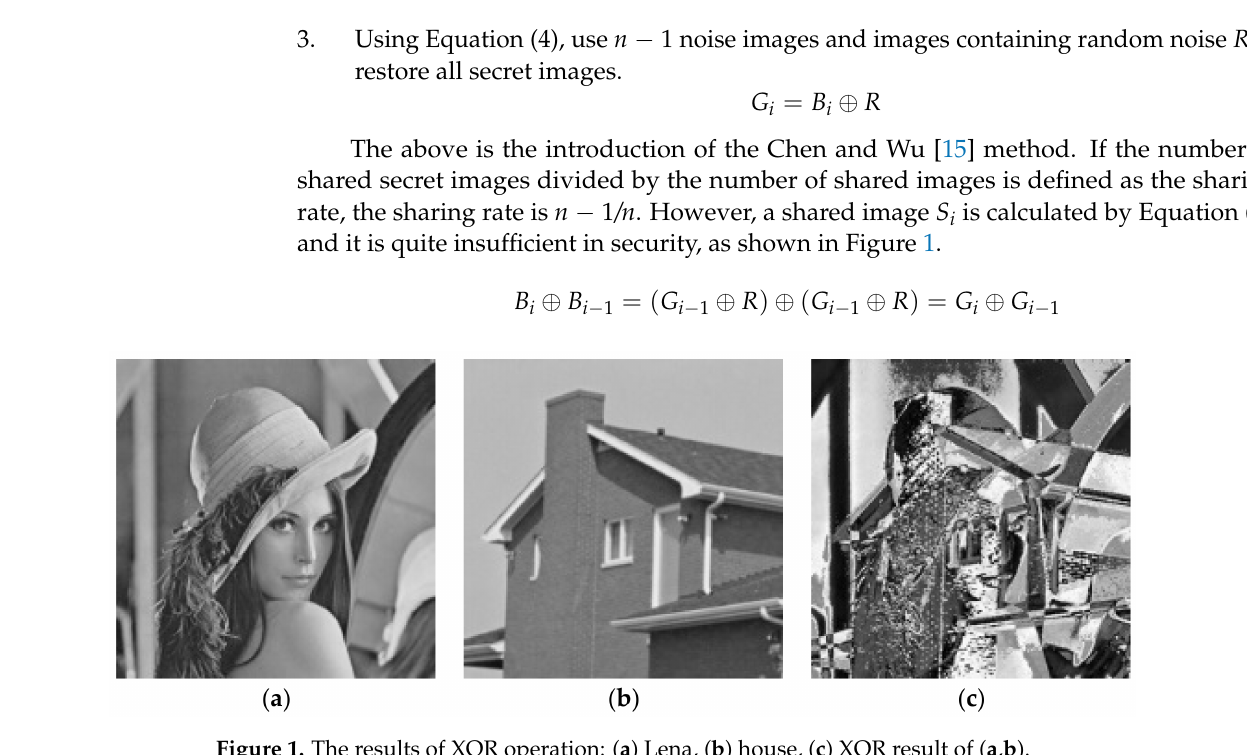
Figure 1. The results of XOR operation: ( a ) Lena, ( b ) house, ( c ) XOR result of ( a , b